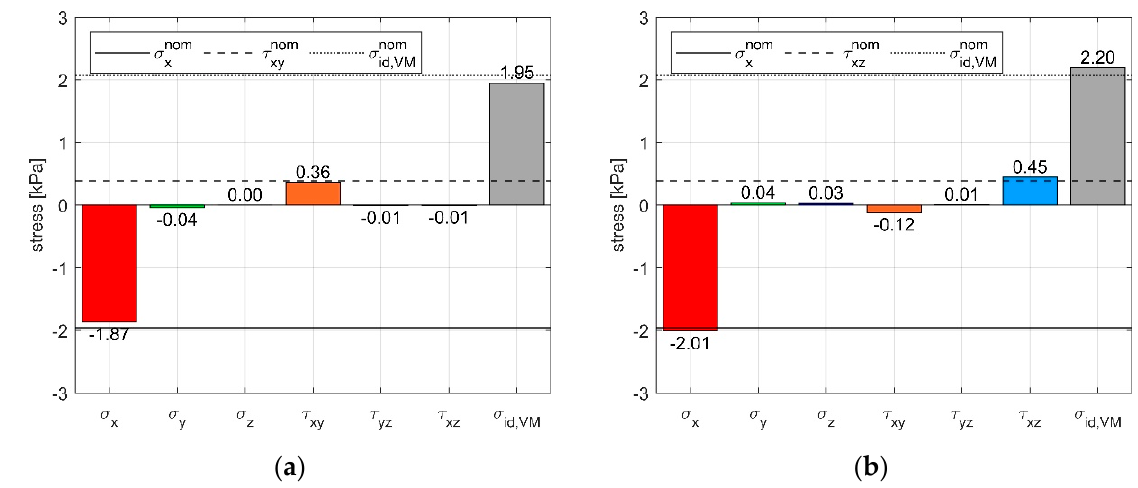
Figure 11. Response of the stress probe under combined loads: ( a ) Compression on X plus shear in XY direction. ( b ) Com- pression on X plus shear in XZ direction.